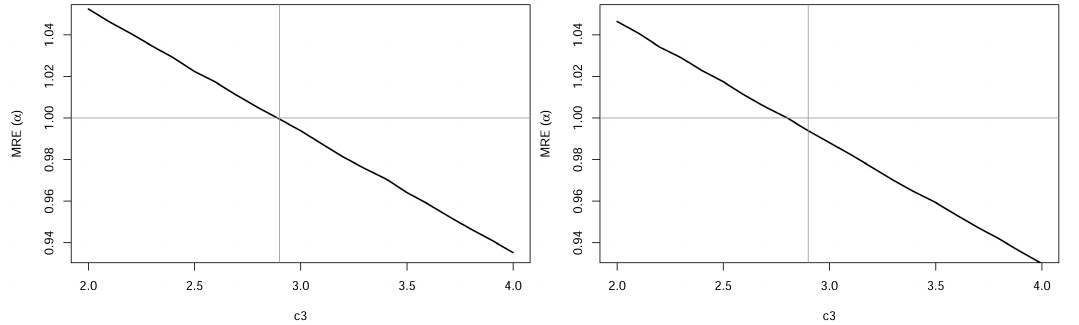
Figure 2 - MREs for α considering c 3 = (2,2.1, ··· ,4) , α = 3 , λ = 4 and n = 20 (left panel) α = 10 , λ = 4 and n = 20 (right panel) for N = 100,000 simulated